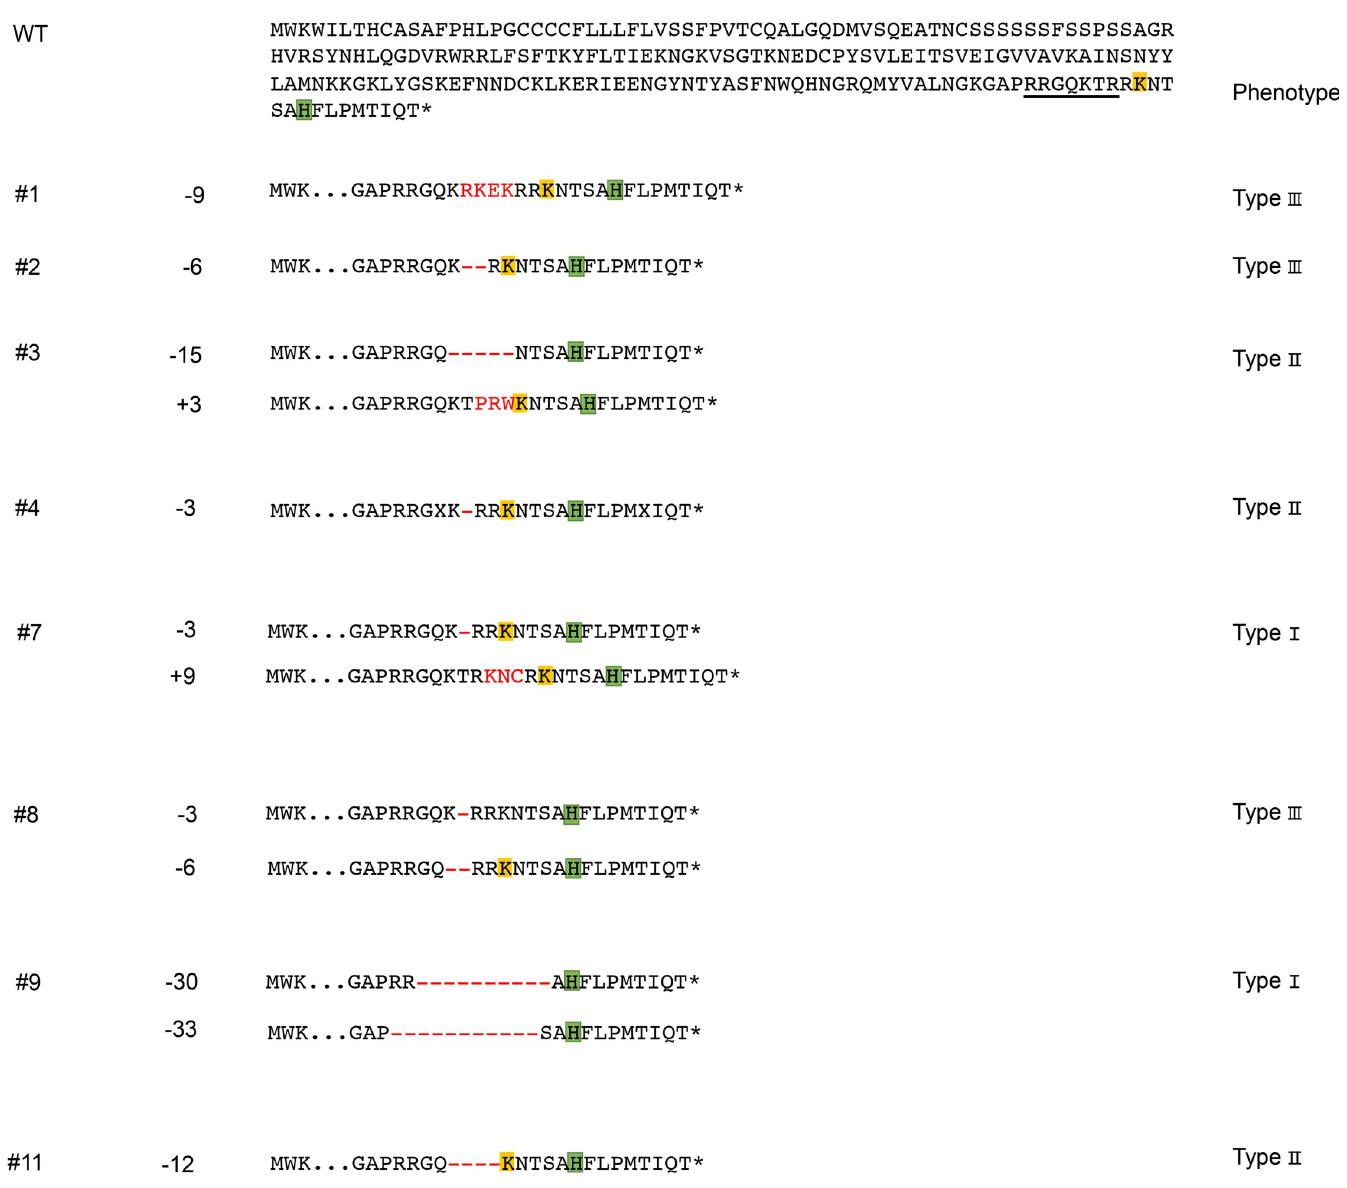
Fig 3. Deduced amino acids for in-frame mutations after deep sequencing. Wild type (WT) sequences are shown on the top. The embryo (E16.5) number (#), nucleotide number of small insertion (+) or deletion (-) (Indels) are shown on the left. Classified “types” are shown on the right. Amino acids corresponding to the guide RNA sequence are underlined. Deleted and altered amino acids are indicated in